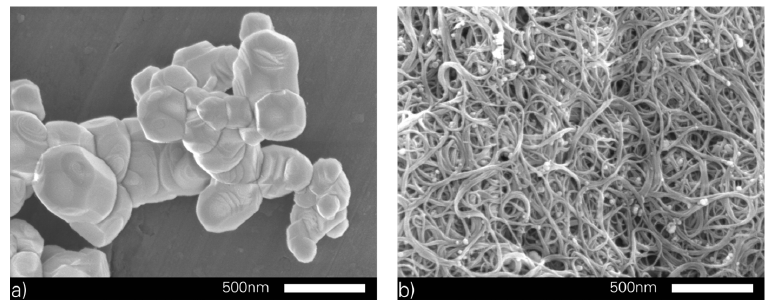
Figure 2. Scanning electron microscopy (SEM) image of ( a ) the perovskite lead magnesium niobate-lead titanate (PMN-PT) produced by Fraunhofer IKTS [15]; and ( b ) single-walled carbon nanotubes (SWCNTs) produced by Fraunhofer IWS [15].